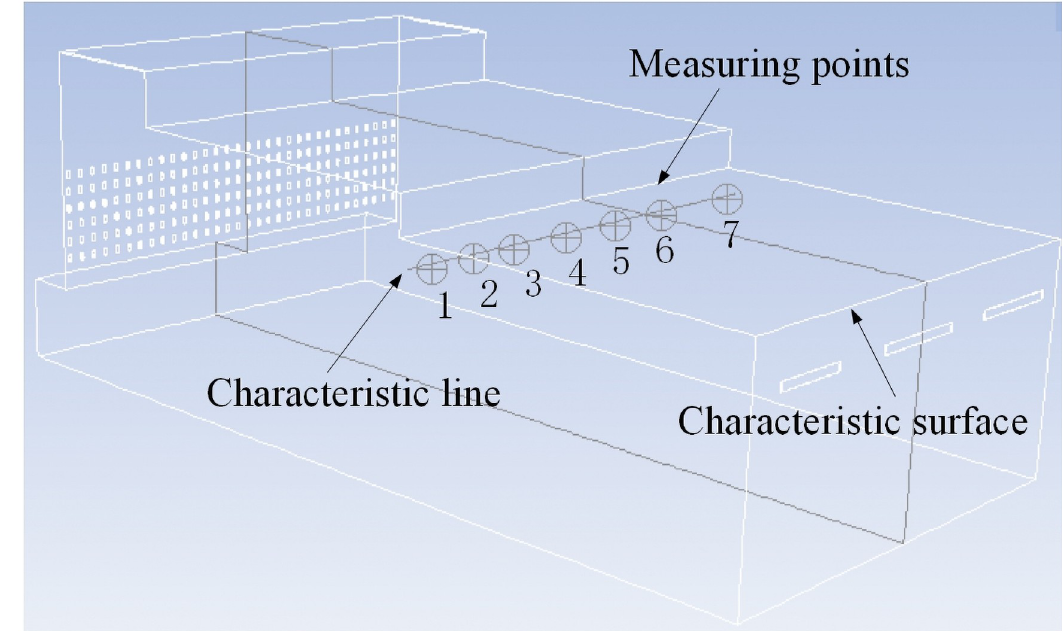
Fig 6. Selection of measuring points, characteristic lines and characteristic surfaces.